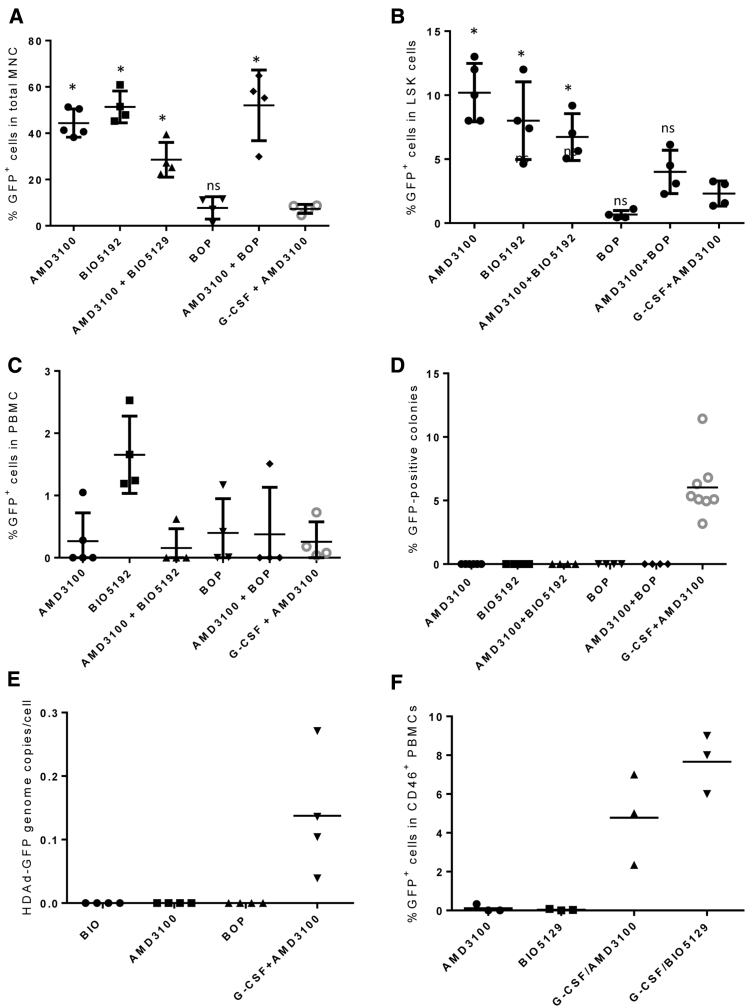
GFP Analysis at 8 Weeks after In Vivo Transduction with HDAd-GFP and HDAd-SB and Different Mobilization Regimens(A–F) hCD46tg mice were mobilized with the indicated agents and i.v. injected with HDAd-GFP + HDAd-SB. (Notably, the vector dose [2 times, 2 × 1010 vp] was half of that used in our previous studies1 and in the studies shown in Figure 1.) Mice were sacrificed at 8 weeks after injection, and bone marrow cells, splenocytes, and PBMCs were harvested. (A) GFP expression in total bone marrow mononuclear cells (MNCs). (B) Percentage of GFP+ cells in LSK cells. (C) Percentage of GFP+ PBMCs. (D) Colony assay. Bone marrow MNCs were depleted for lineage-positive cells, sorted for GFP+ cells, and plated for progenitor colonies assays. Shown is the percentage of GFP+ colonies that formed after 14 days. (E) HDAd-GFP vector DNA copies in pooled colonies. qPCR with primers specific to the GFP cassette using genomic DNA from pooled colonies derived from plated lin−/GFP+ cells. Each symbol is the result of pooled colonies from a given animal. (F) Transplantation assay. Bone marrow cells harvested from in vivo-transduced hCD46 transgenic mice were transplanted into C57BL/6 mice. Shown is the percentage of GFP+ cells in hCD46+ PBMCs at week 8 after transplantation. *p < 0.05.